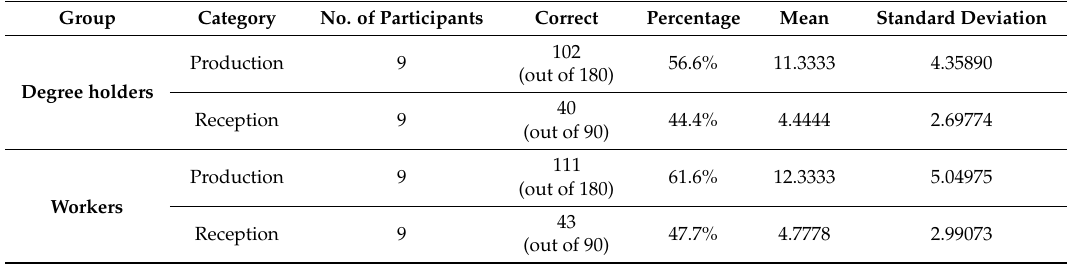
Table 1. Mean Scores of Workers and Degree Holders on Production and Reception Tests.